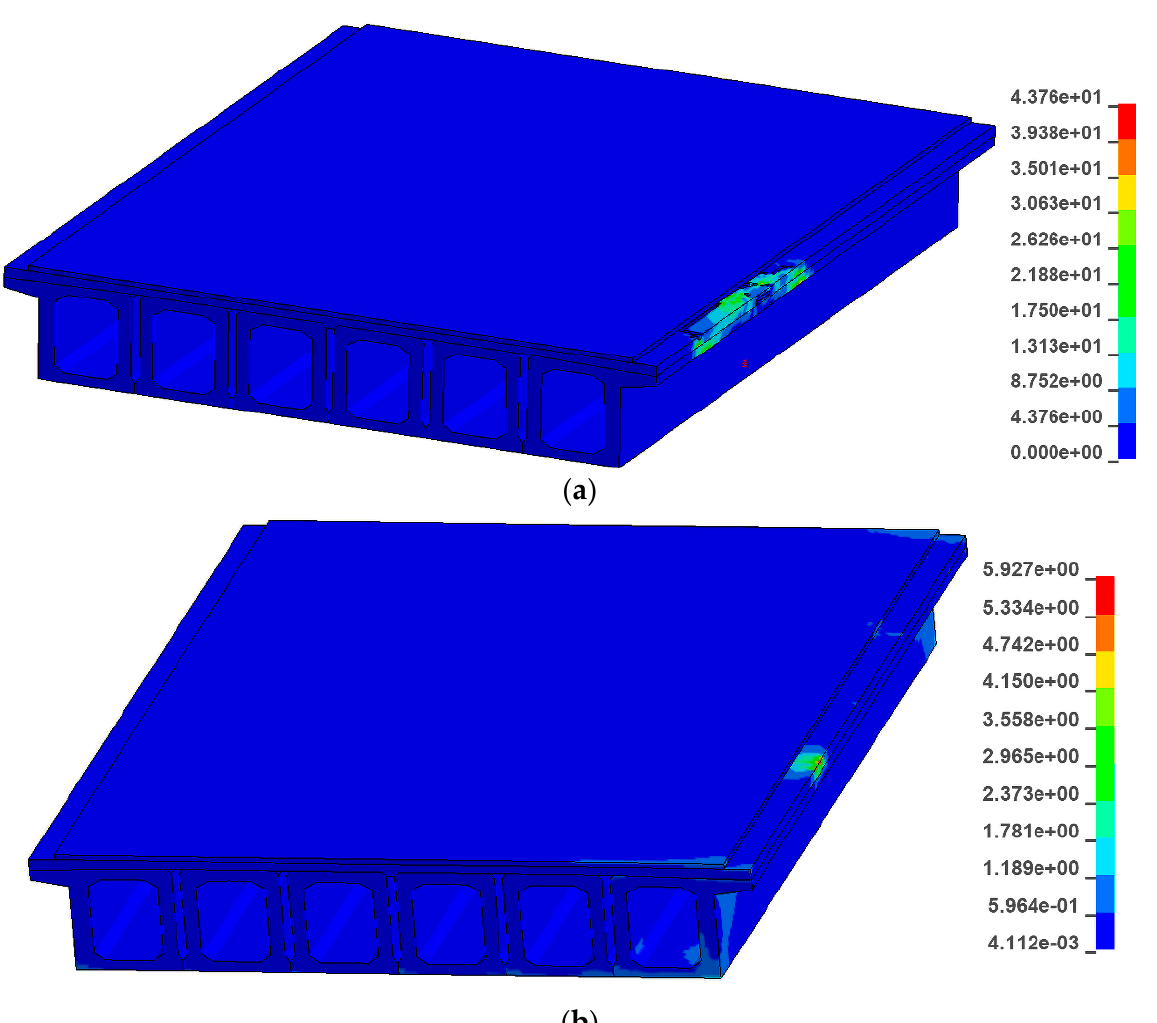
Figure 17. Maximum tensile stress diagram: ( a ) fabricated guardrail and ( b ) traditional guardrail.